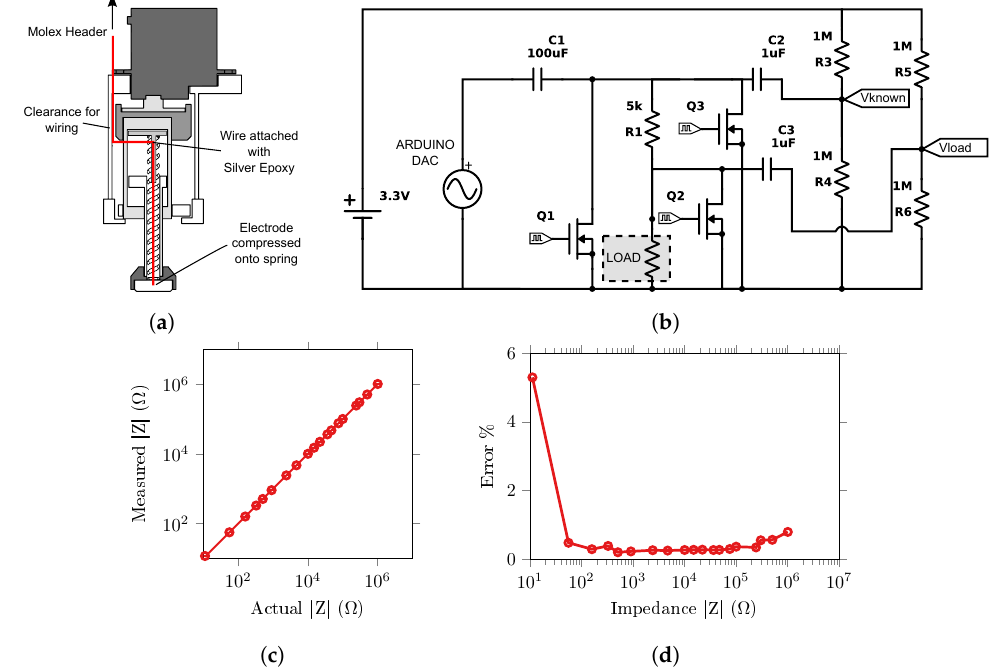
Figure 10. Single Unit Impedance Measurement ( a ) wiring path to electrode ( b ) circuit diagram ( c ) impedance measured across expected measurement range compared to ideal ( d ) percentage